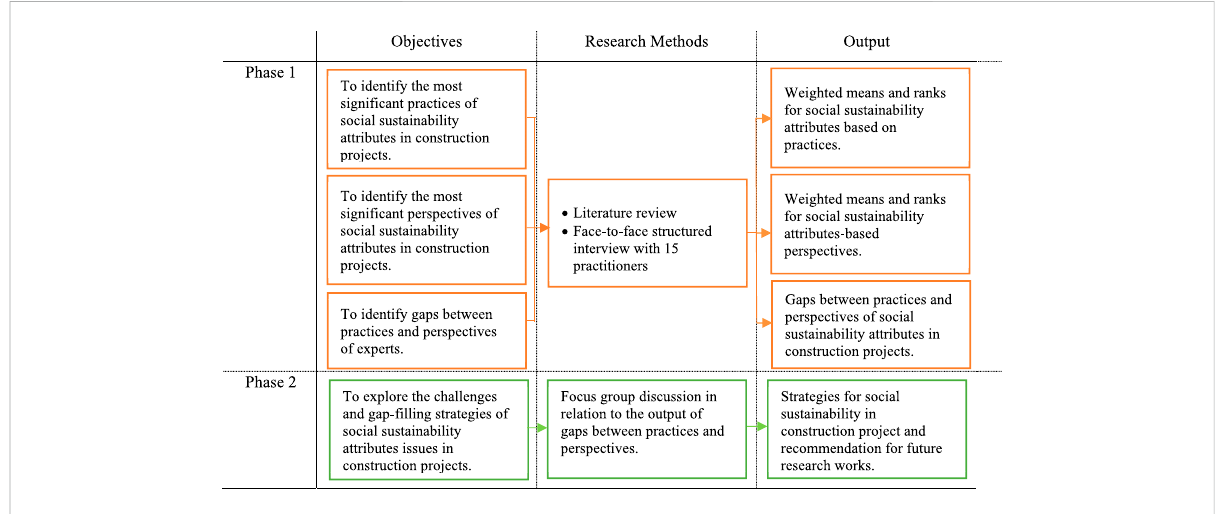
FIGURE 1 Structure of Research Methodology.